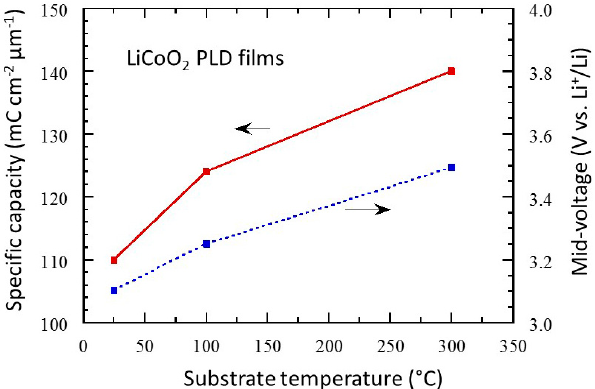
Figure 4. Electrochemical features of PLD-grown LCO thin films: specific discharge capacity and discharge mid-voltage vs. substrate temperature.